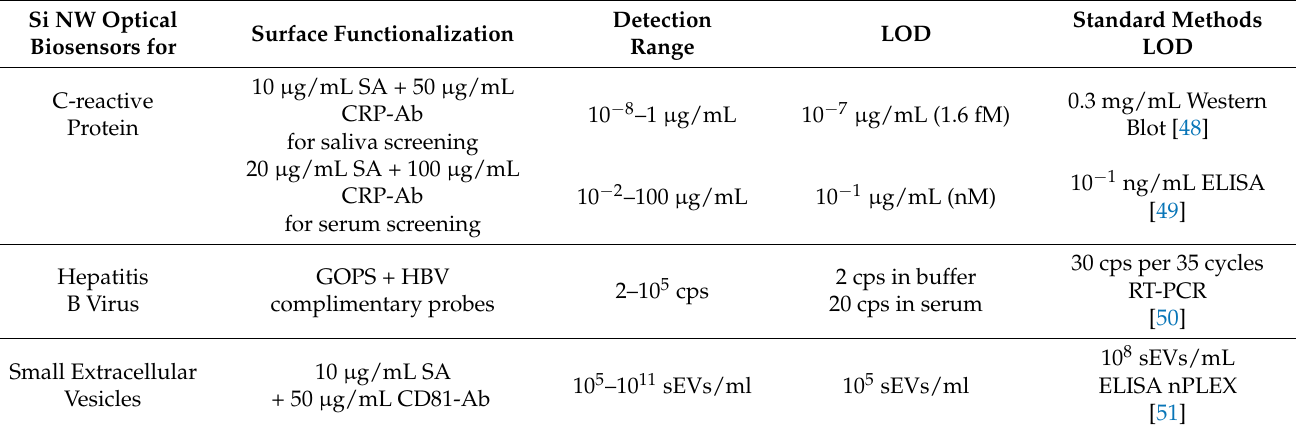
Table 1. Characteristics of Si NW optical